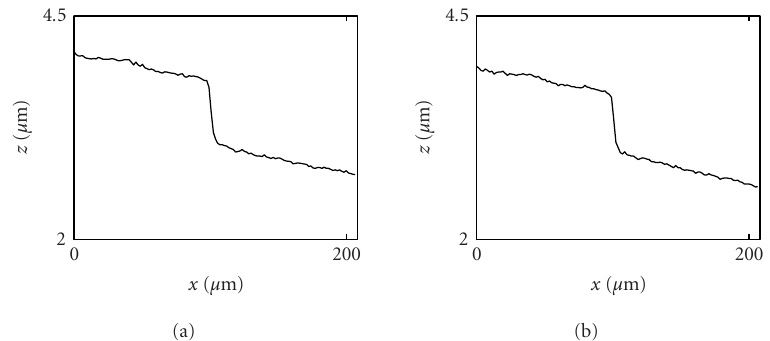
Figure 13: Surface profiles using undersampled data. (a) ( k , m ) = (4,2) and T e = 120 nm and (b) ( k , m ) = (0,1), T e = 240 nm.